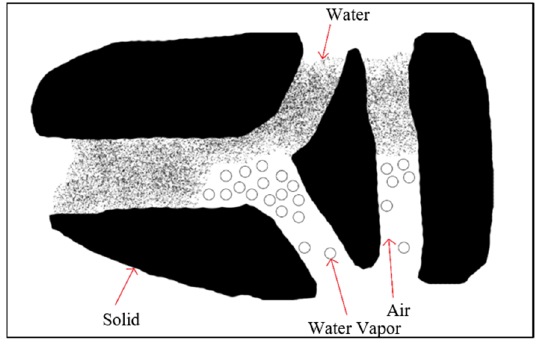
Figure 1. Structural scheme of porous